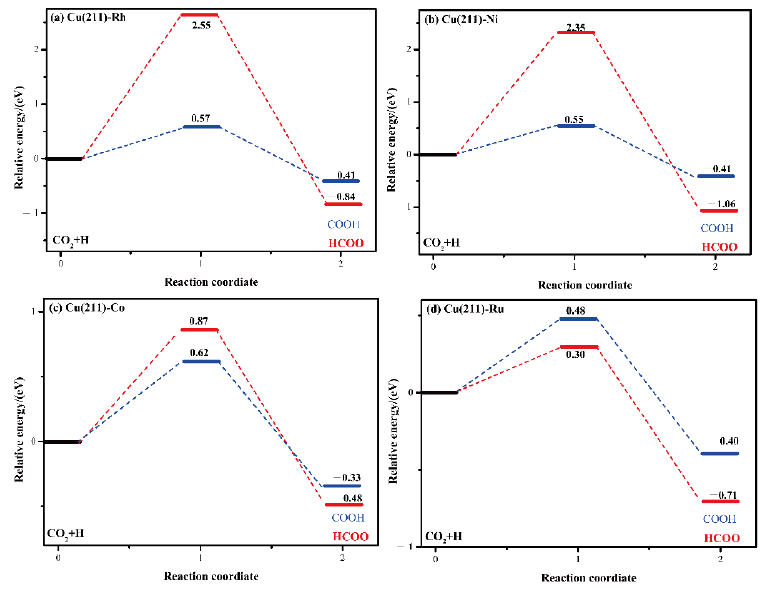
Figure 5. Energy pro fi les for CO 2 hydrogenation to COOH and HCOO on ( a ) Cu(211)-Rh, ( b ) Cu(211)-Ni, ( c ) Cu(211)-Co, and ( d ) Cu(211)-Ru surfaces.